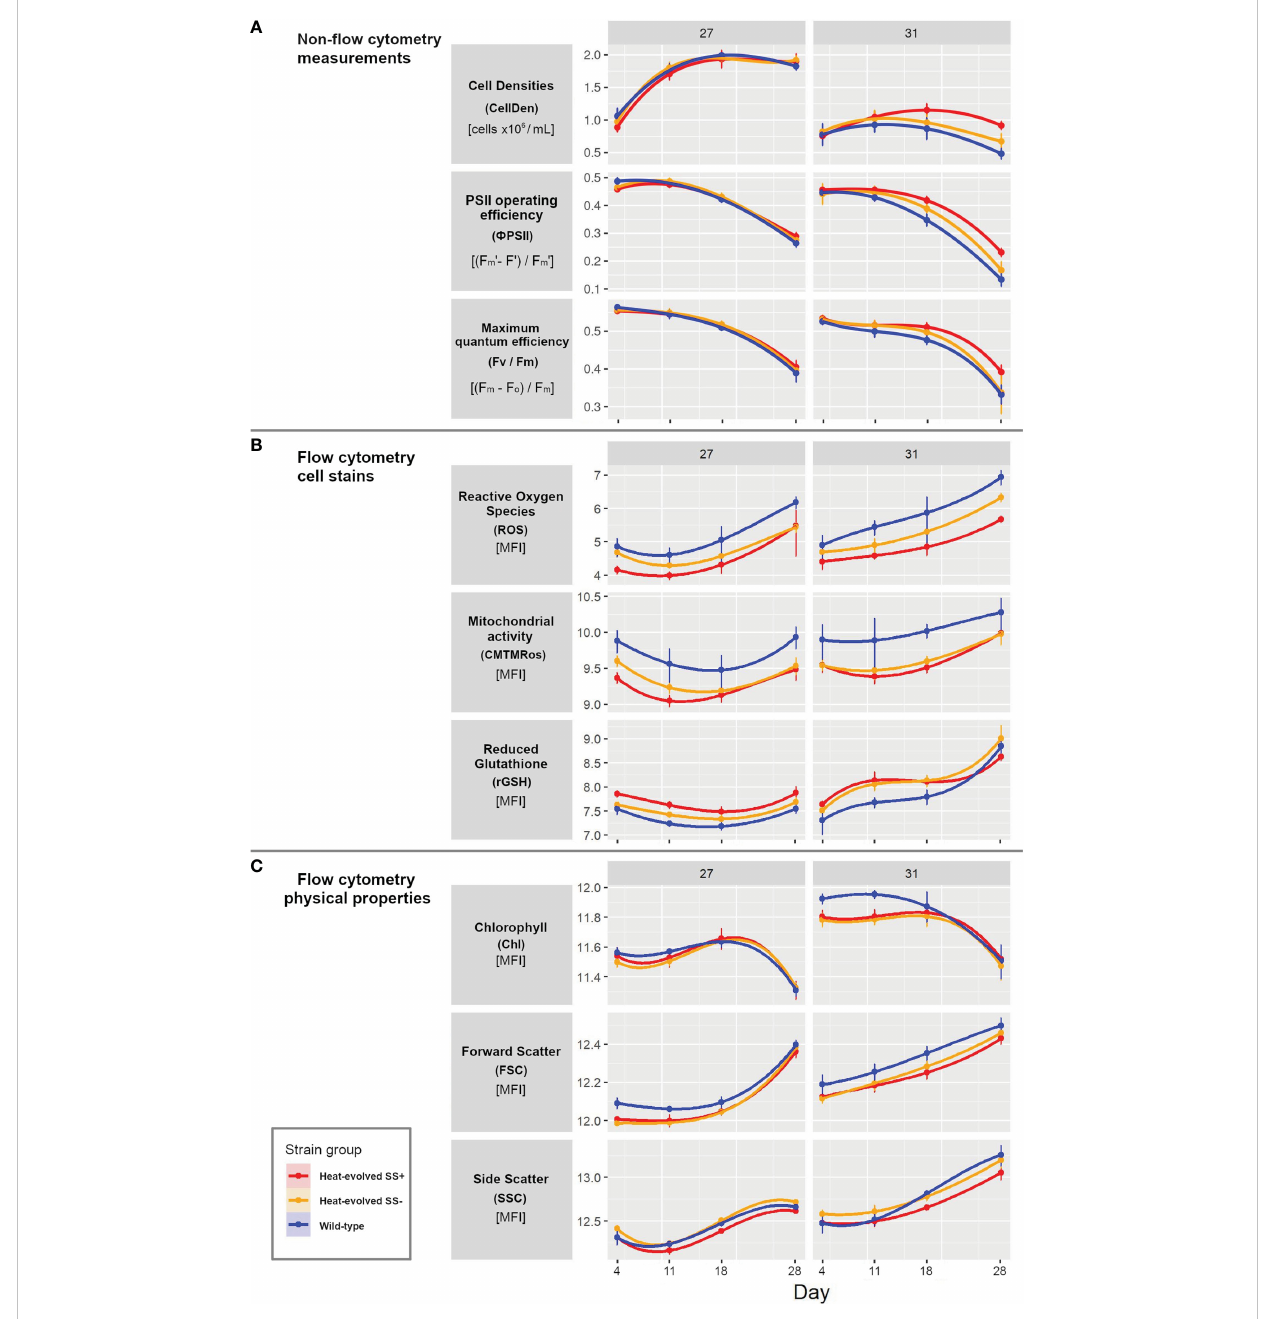
FIGURE 2 Progress curves for the three strain types for each variable and temperature. (A) Non- fl ow cytometer measurements of cell density, PSII operating ef fi ciency and maximum quantum ef fi ciency. (B) Flow cytometry cell dye measurements of reactive oxygen species (CellROX Orange), mitochondrial activity (MitoTracker Orange, CMTMRos) and reduced glutathione (VitaBright-48), all displayed as median fl uorescent intensity [MFI]. (C) Flow cytometry measurement of the physical properties photosynthetic pigments, and cell size and shape (forward and side scatter respectively). Panel (A) is showing raw data values, while panel (A, B) are presented on natural log scales [log(data point +1)]. Error bars show 95% con fi dence intervals based on 5 or 6 replicates and assuming t distributions. Measurements were taken on Days 4, 11, 18 and